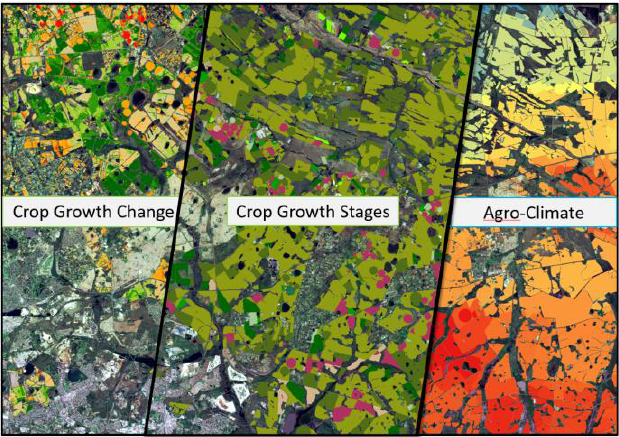
Figure 2: Illustration of information provided in the GeoFarmer web-based